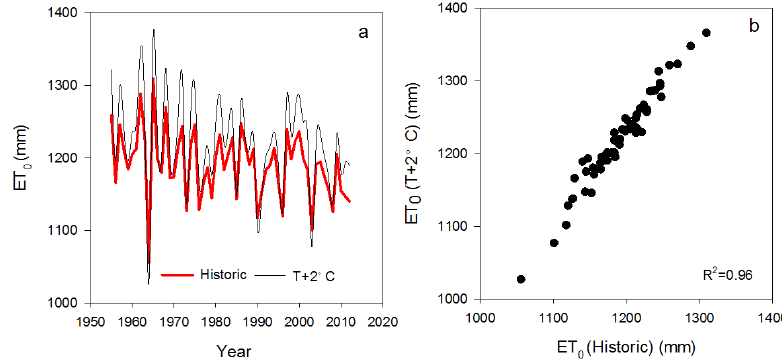
Figure 5. The comparison of ET 0 under historic and changing climate conditions with daily temperature increase of + 2 ◦ C.